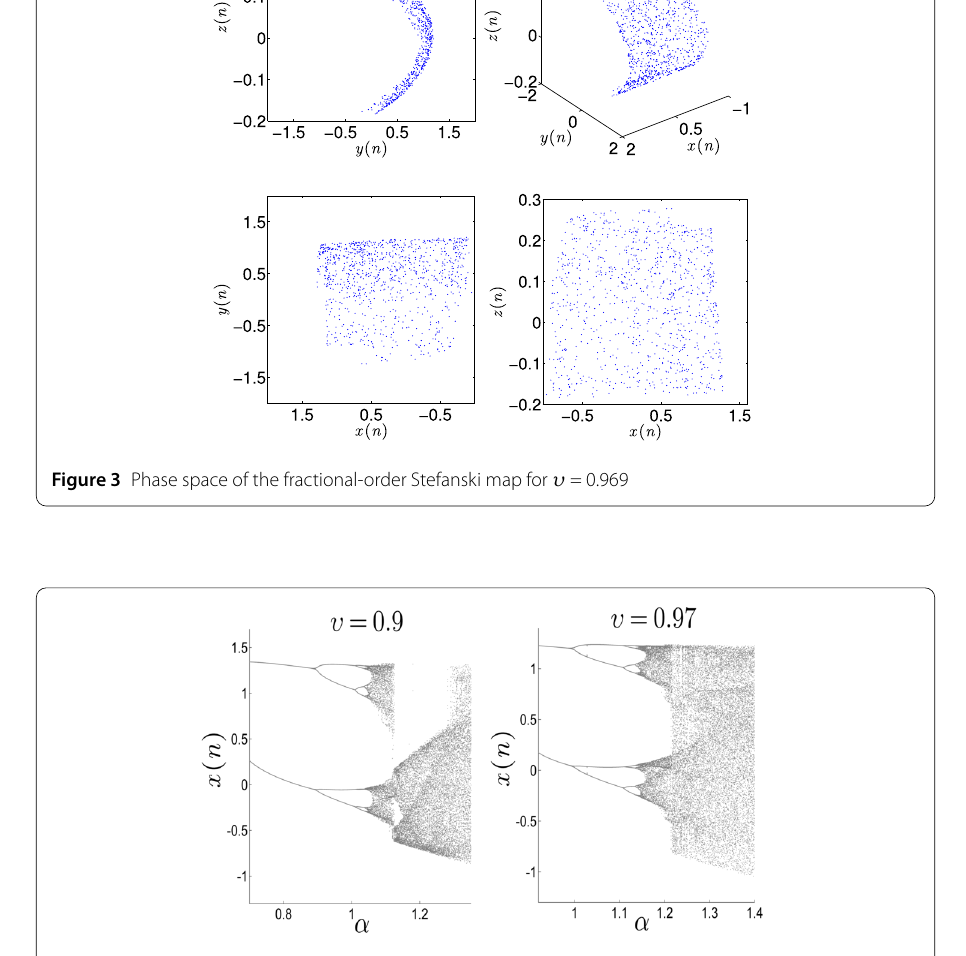
Figure 4 Bifurcation diagrams corresponding to the fractional Stefanski map with α as the critical parameter, β = 0.2, and different fractional orders